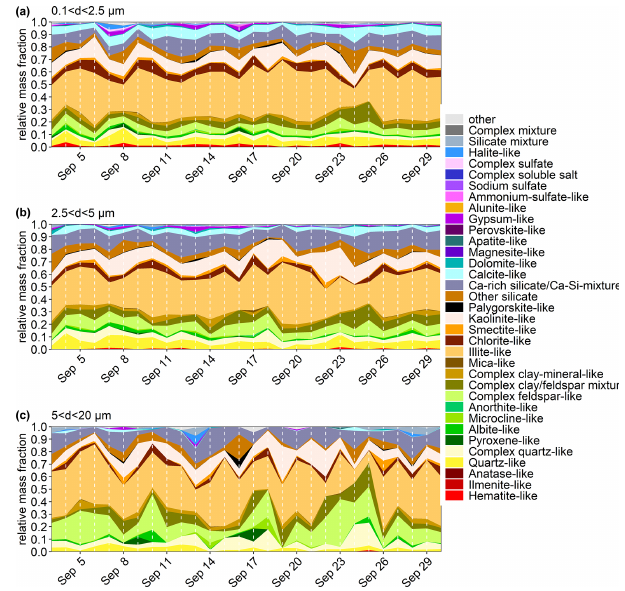
Figure 6. Time series of chemical composition for particles of (a) 0.1 <d < 2.5µm, (b) 2.5 <d < 5µm, and (c) 5 <d < 20µm at